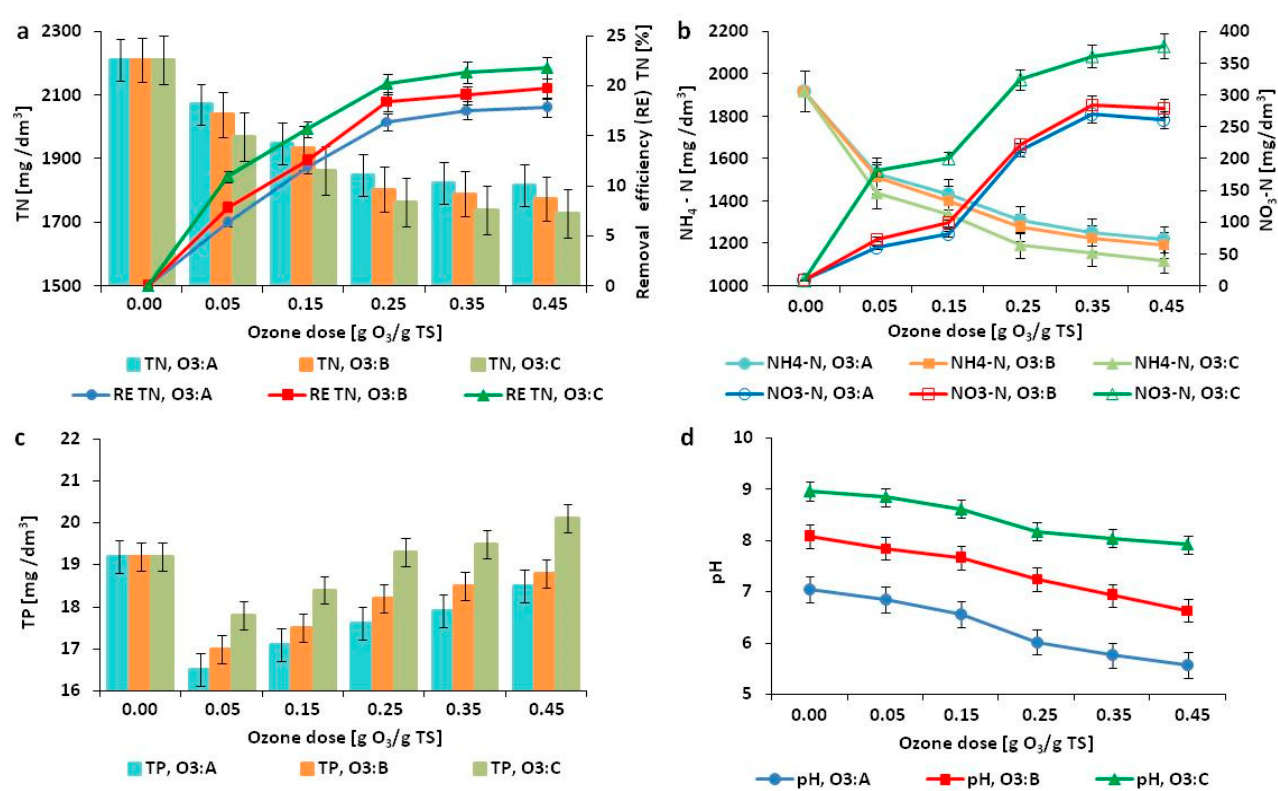
Figure 2. Removal efficiency of TN ( a ); concentration of TN ( a ), NH 4 –N and NO 3 –N ( b ), TP ( c ); pH value ( d ) depending on ozone dose and initial pH during ozonation of digestate liquid fraction.